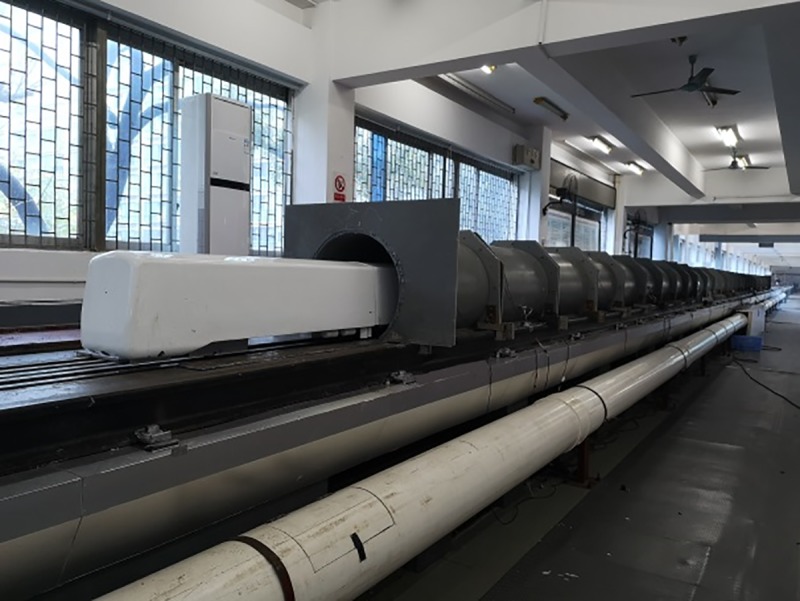
Train-tunnel model.